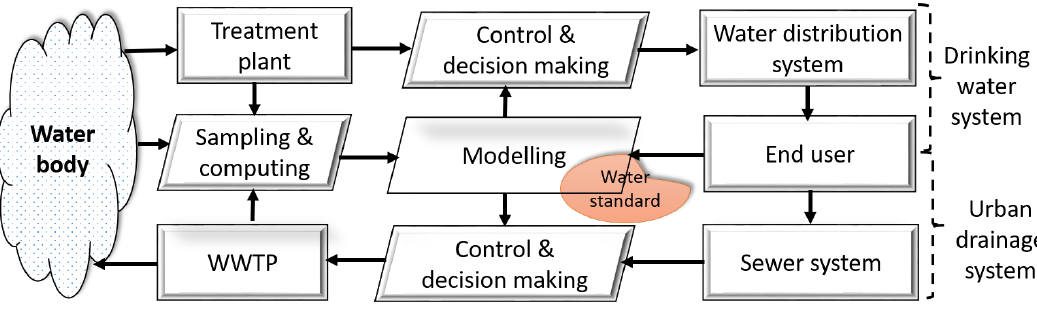
Figure 5. A CPS for the control of urban water cycle